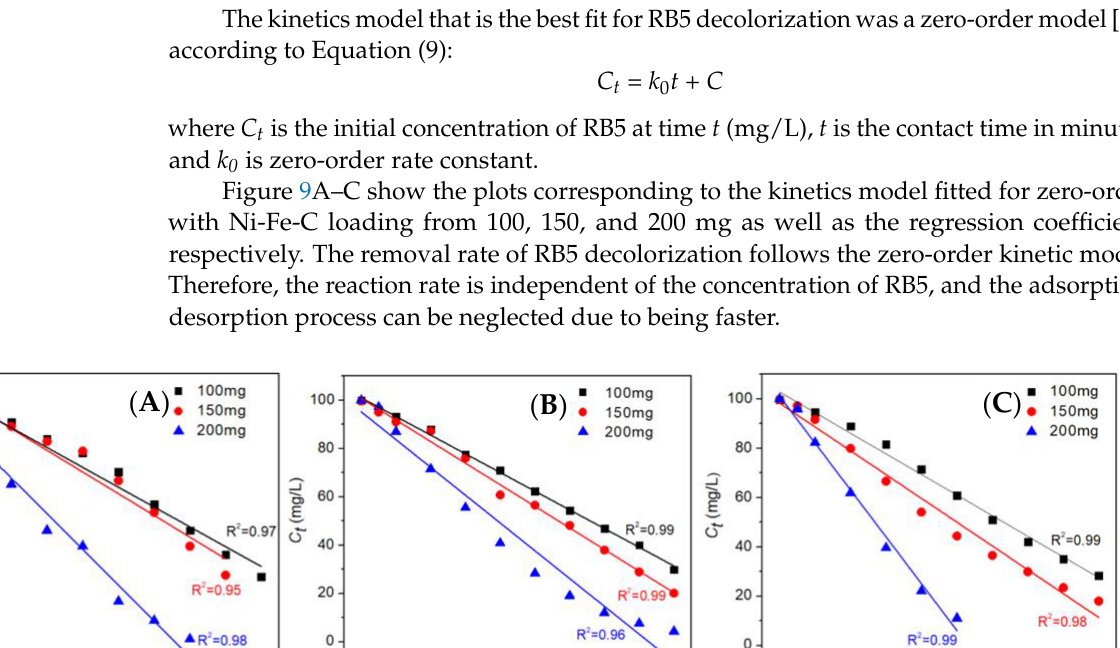
and k 0 is zero-order rate constant.